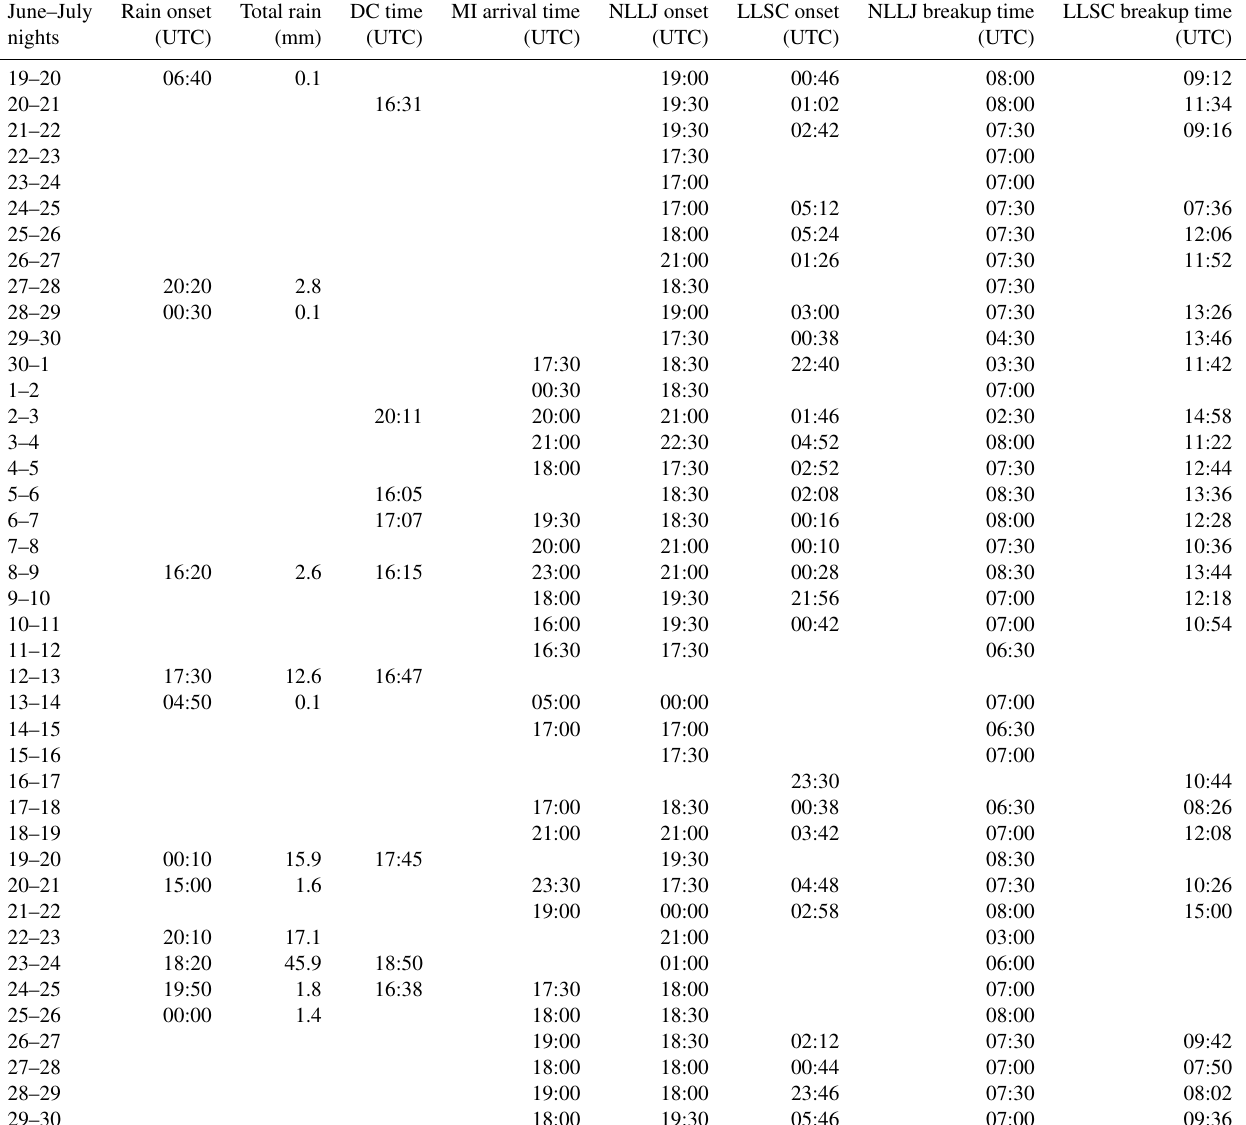
Table 1. Characteristics (onset and breakup time) of the NLLJ and LLSCs and the arrival time of the MI at Savé during the 20 June– 30 July 2016 period. All times are indicated in UTC. For times related to the LLSCs, blanks indicate that LLSCs were not detectable (because of rain or clear sky). For times related to MI or NLLJ, blanks indicate missing data or undetectable features. The FLF mean was used to estimate the MI onset. DC indicates density